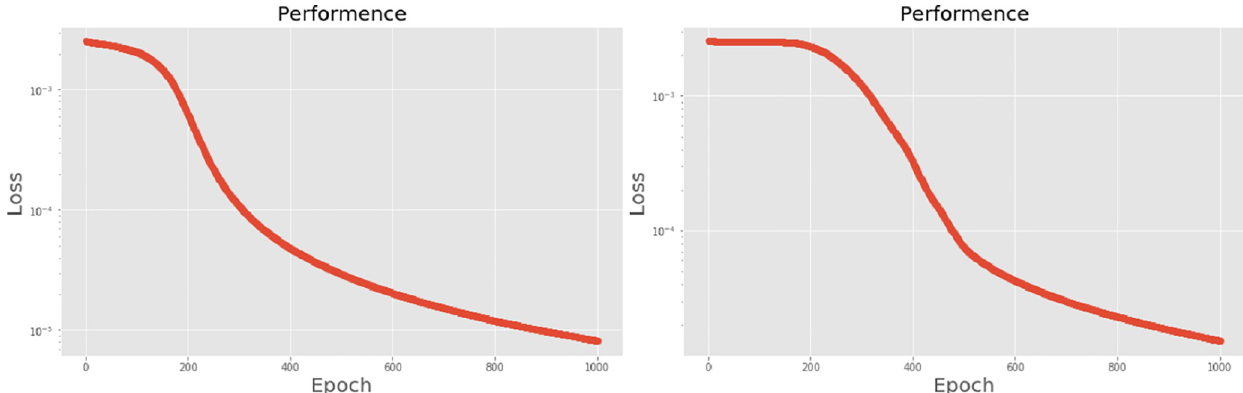
Fig 26. (a) The graph shows the performance of MFCC-LSTM-2 × 300 model; (b) The graph shows the performance of MFCC-PCA-LSTM-2 × 300 model.